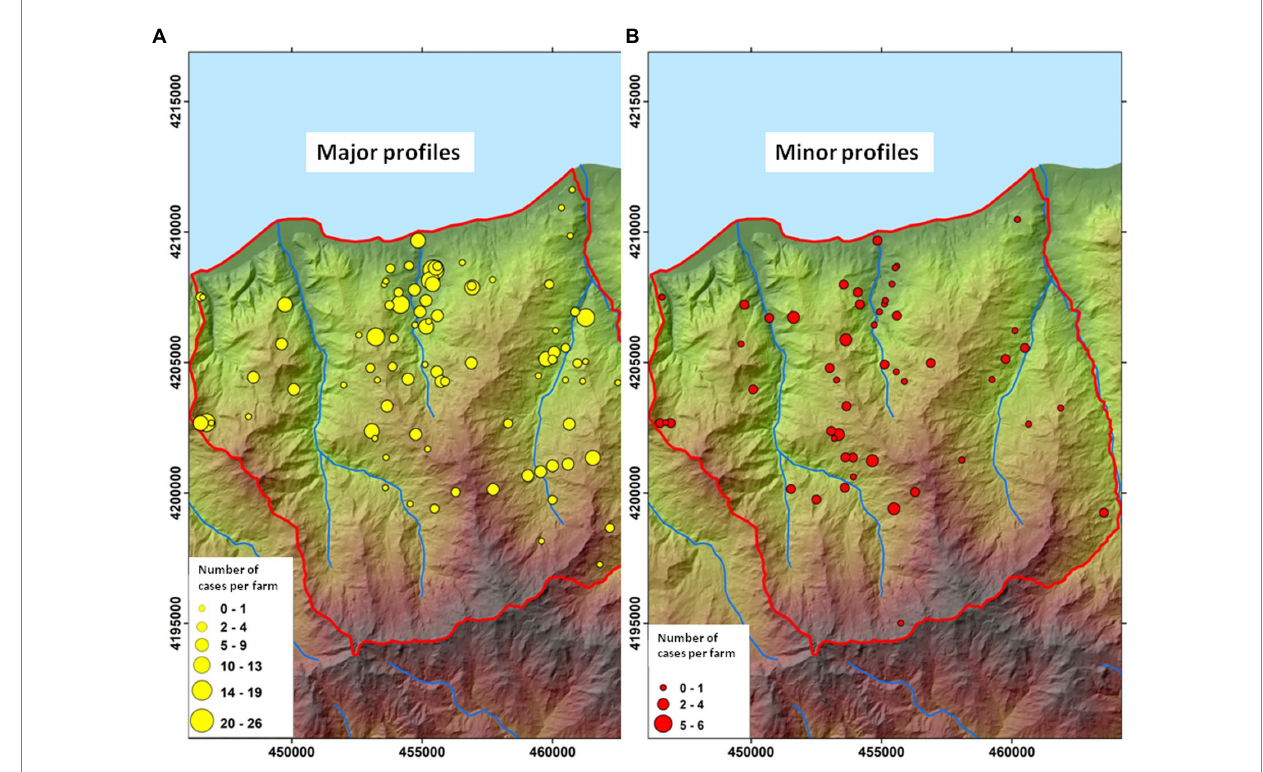
FIGURE 6 Geographic distribution of Mycobacterium bovis genotypes. (A) farms affected by major M. bovis profiles ( n = 90). (B) Farms affected by minor M. bovis profiles ( n = 53). The size of the dots is proportional to the number of infected animals (cattle and black pigs) per herd. Both maps were adapted from